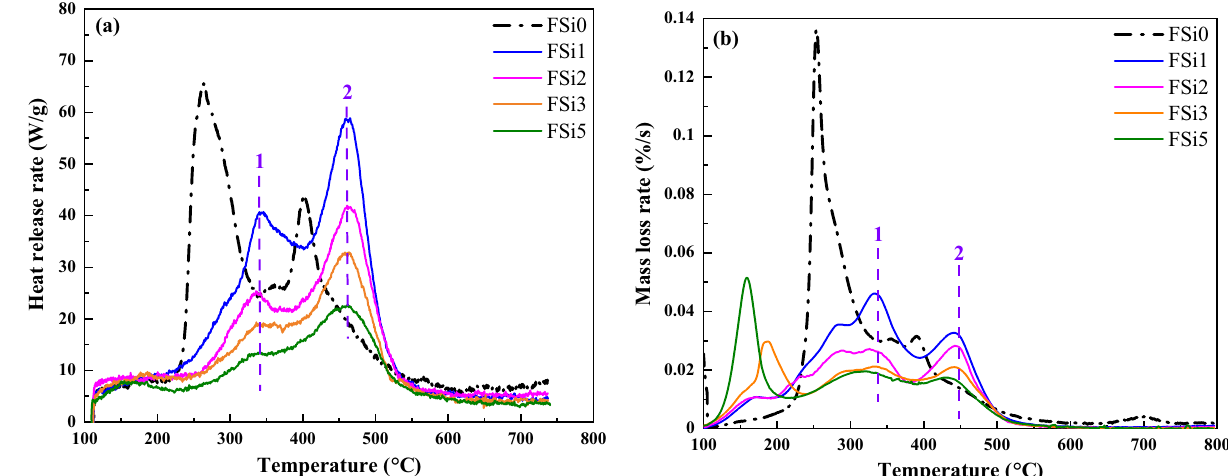
Figure 8. ( a ) The heat release rate at different temperature for fungal fibers grown with different concentration of Si source in the MCC test; ( b ) the calculated mass loss rate for fungal fibers grown with different concentration of Si source from the TGA